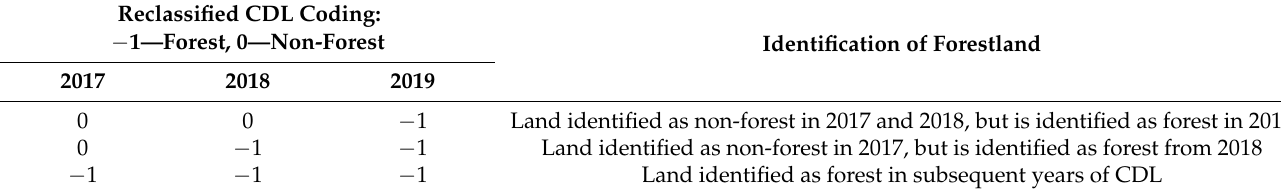
Table 3. Tracing the land identified as forest in 2016 NLCD, but identified as non-forest in 2016 CDL using the subsequent years CDL